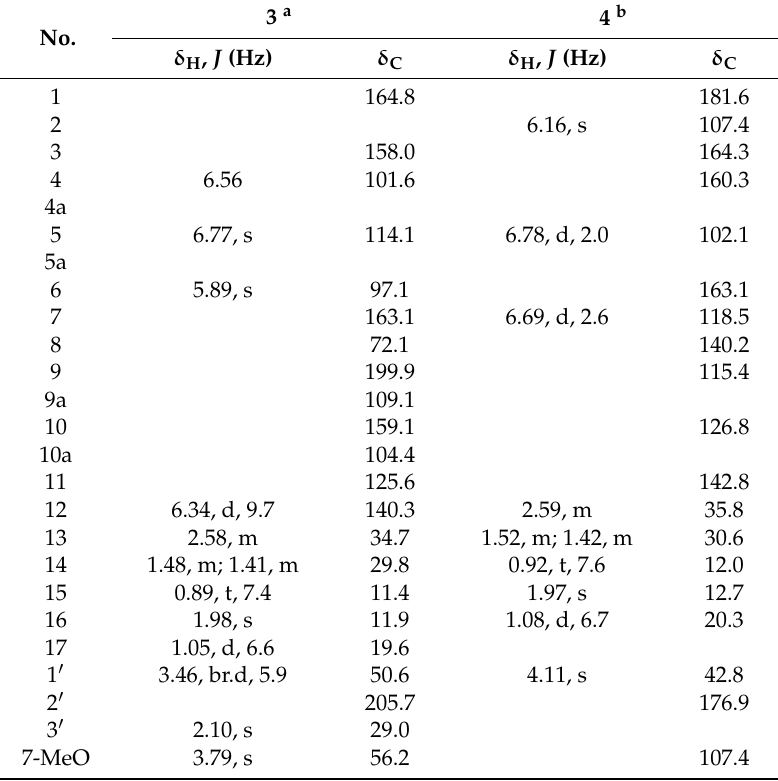
Table 2. NMR spectroscopic data for compounds 3 (acetone- d 6 ) and 4 (MeOH- d 4 ). 3 a 4 b No. δ H , J (Hz) δ C δ H , J (Hz) δ C 1